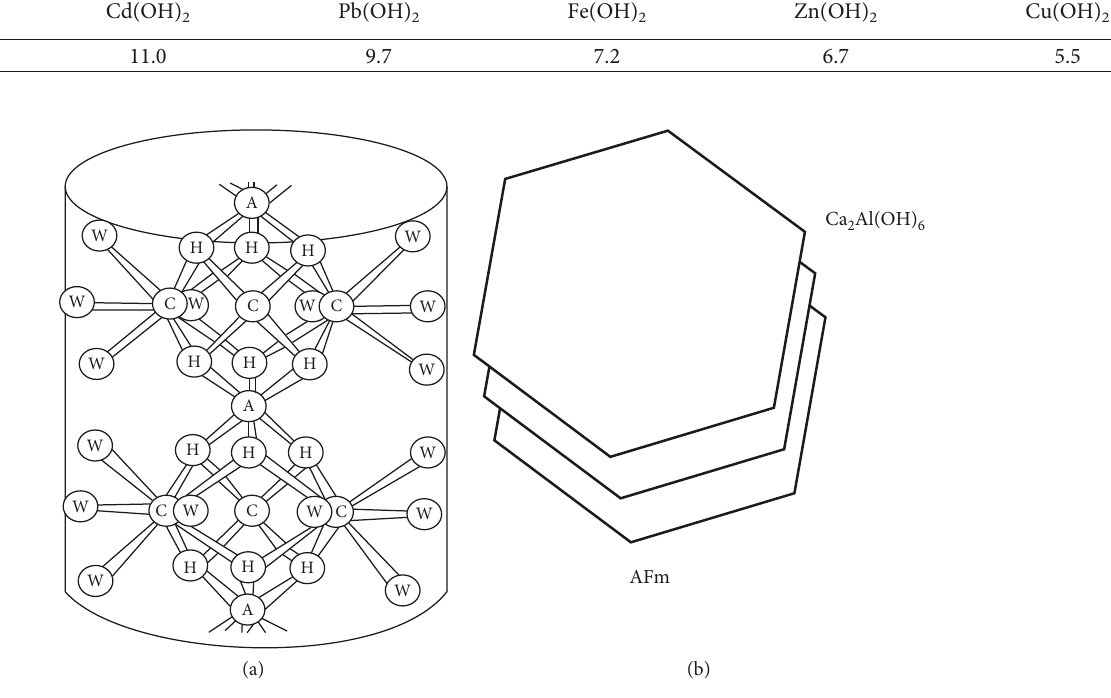
Figure 1: Cellular structure of AFt and